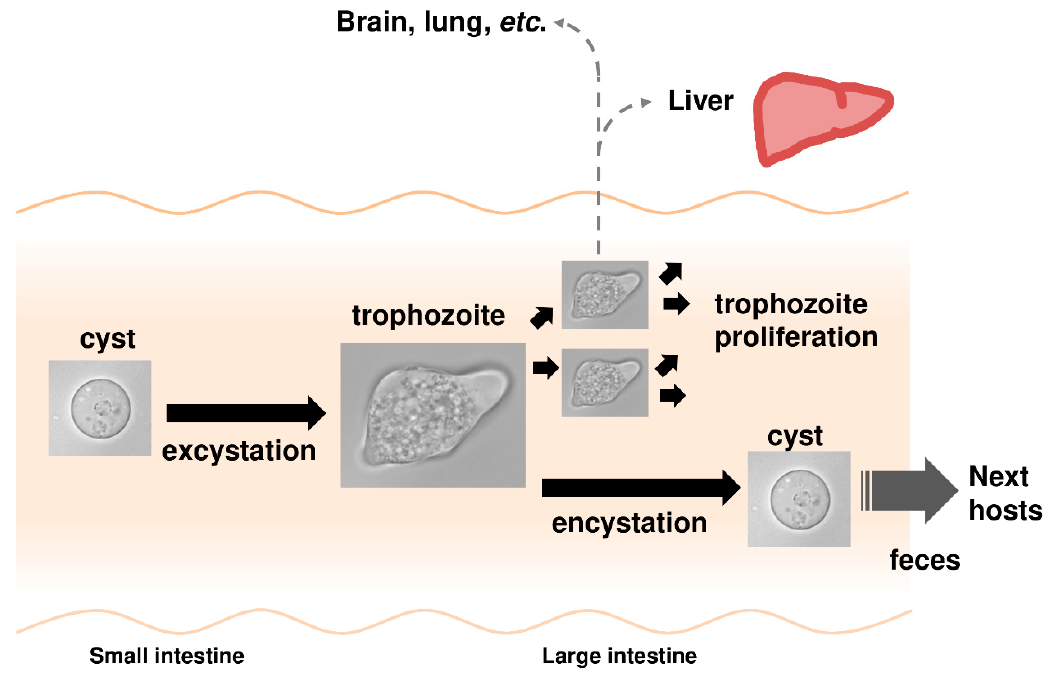
Figure 2. Entamoeba histolytica , the causative agent for amoebiasis. Schematic illustration of the main route of infection and behavior inside the human host is shown. The life cycle of E . histolytica essentially consists of proliferative trophozoite and dormant cyst stages.